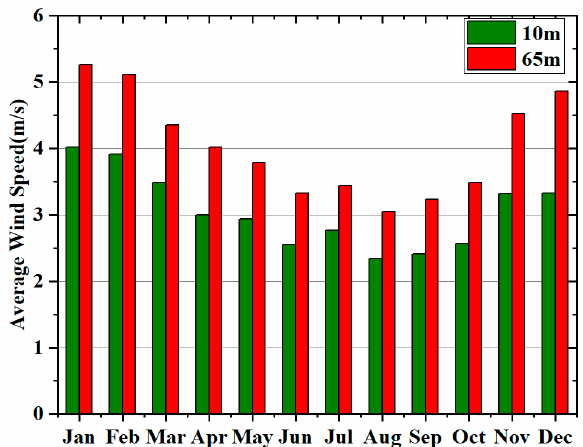
Figure 1. Monthly average wind speed for 10 m and 65 m hub heights.